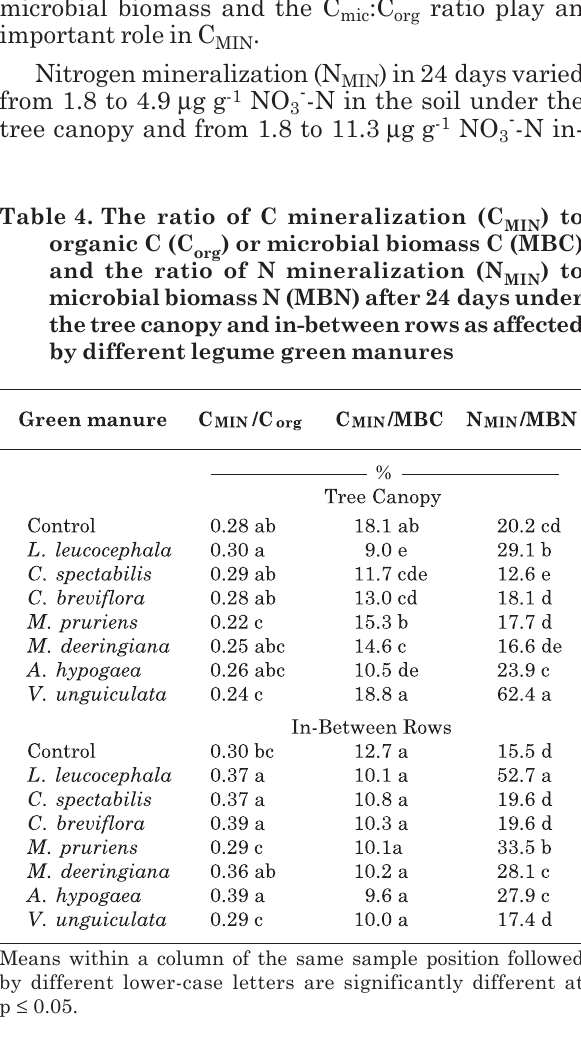
Means within a column of the same sample position followed by different lower-case letters are significantly different at p ≤ 0.05.